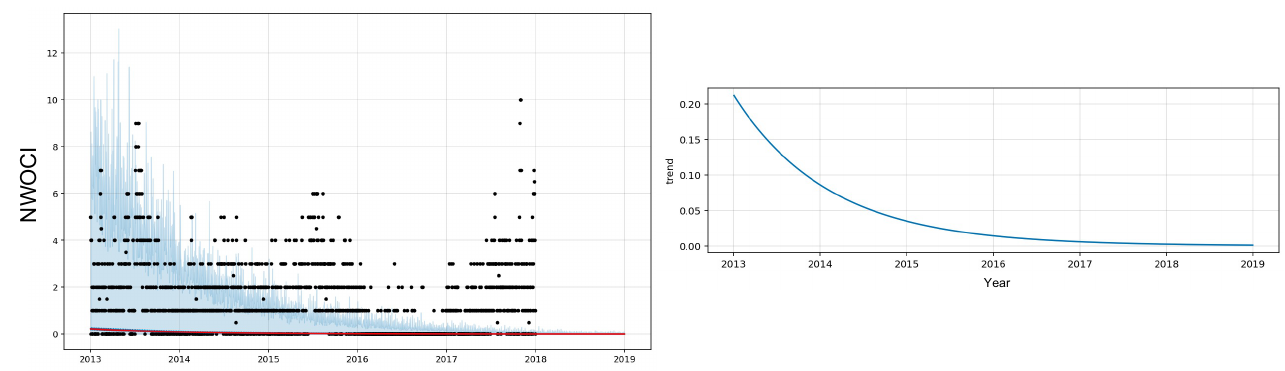
Figure A1. Left : One year forecast result (2018 test data) from Prophet-BU Model for Barnstable county in MA. N.B: The solid blue line shows the average forecast while the solid red line shows the observed trend of NWOCI and the light blue region represents the 80% confidence interval for the forecast uncertainty. Also, the scatter points represent the historical values in the training data (2013–2017). Right : Trend decomposition from Prophet-BU Model for Barnstable county in MA.